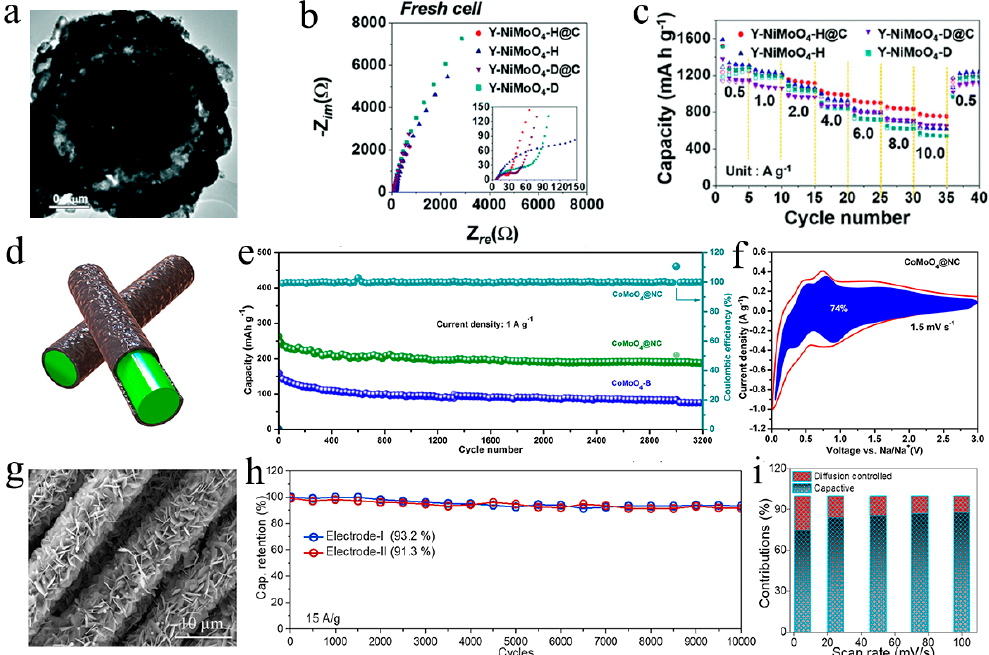
Figure 5. ( a ) TEM image of N-doped carbon coated hollow NiMoO 4 nanospheres. ( b ) Nyquist plots of Y-NiMoO 4 -H@C, Y-NiMoO 4 -H, Y-NiMoO 4 -D, and Y-NiMoO 4 -D@C of fresh cells. ( c ) Rate performances of Y-NiMoO 4 -H@C. Reproduced with permission. [71] Copyright 2019, The Royal Society of Chemistry. ( d ) Schematic illustration of CoMoO 4 @NC nanorods; the green part is rod-like CoMoO 4 , and the coated part is N-doped carbon coatings. ( e ) Long-term cyclic performance at 1 A g − 1 of CoMoO 4 @NC and CoMoO 4 -B. ( f ) The separation of the capacitive and diffusion currents of Co- MoO 4 @NC at a scan rate of 1.5 mV s − 1 ; the capacitive contribution to the total current is presented by the shaded region. Reproduced with permission. [73] Copyright 2020, Elsevier Inc. ( g ) SEM of CoMoO 4 @CFC (hexagonal nanosheets CoMoO 4 are grown on the Carbon Fabric Cloth). ( h ) Cycling performance up to 10,000 cycles at current density of 15 A g − 1 for two separate electrodes. ( i ) Capac- itive and diffusive contribution at different scan rates. Reproduced with permission. [74] Copyright 2020, Elsevier Ltd. and Techna Group S.r.l. Recently, Zhu’s group [73] designed N-doped carbon-encapsulated CoMoO 4 (Co- MoO 4 @NC) nanorods by a facile co-precipitation method to obtain a long-cycle-life anode material for sodium-ion battery. As shown in Figure 5d, the N-doped carbon shell acts as a cushion to adapt to gross volume changes during Na + insertion/extraction while enhanc- ing the electronic conductivity and activating the surface sites of CoMoO 4 . In fact, it shows a prolonged cycle life, especially at a high current density of 1 A g − 1 (Figure 5e). Interest- ingly, the calculated capacitive current of CoMoO 4 @NC shows that 74% of the total charge contributions are quantified as capacitive (Figure 5f). Analogously, Hussain and cowork- ers [74] reported a CoMoO 4 /C composite by co-friendly hydrothermal method as a posi- tive electrode for pseudocapacitors. Binder-free CoMoO 4 hexagonal nanosheets (SEM is shown in Figure 5g) were directly grown on the surface of conductive carbon fabric cloth (CoMoO 4 @CFC), and the hexagonal-like 2D structure possesses mesoporous characteris- tics (BET = 68 m 2 g − 1 ) with abundant electroactive sites as the main body of charge storage. The electrochemical properties show that the material has excellent cycling stability as the capacitance retained up to 93.2% after up to 10,000 cycles, especially at a high current density of 15 A g − 1 (Figure 5h). In addition, Figure 5i indicates the capacitive charge stor- age contributions at different scan rates and, accordingly, the CoMoO 4 @CFC electrode was attributed to a high capacitive charge value of 75% at 2.5 mV s − 1 . Using carbon-based